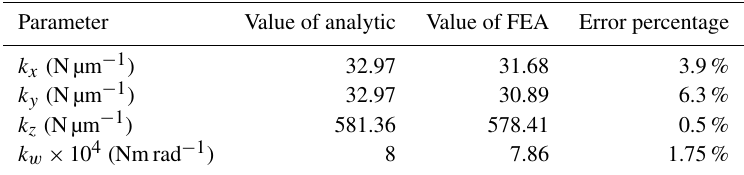
Figure 3. Deformation with force/moment imposed. Table 3. The results of calculation and finite-element